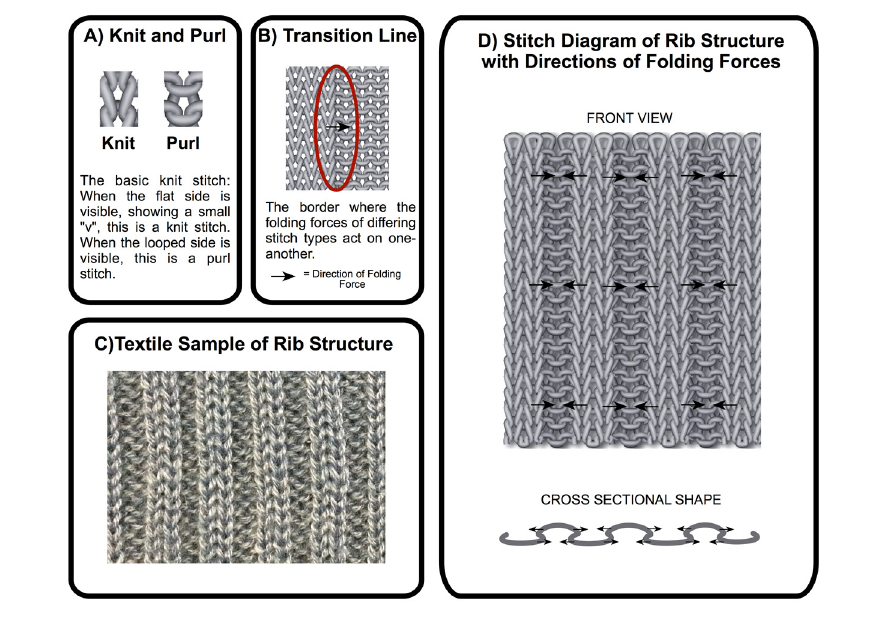
Figure 1. Self-folding in knits: ( A ) knit and purl stitches; ( B ) transition line; ( C ) textile sample of rib structure; ( D ) stitch diagram of rib structure with directions of folding